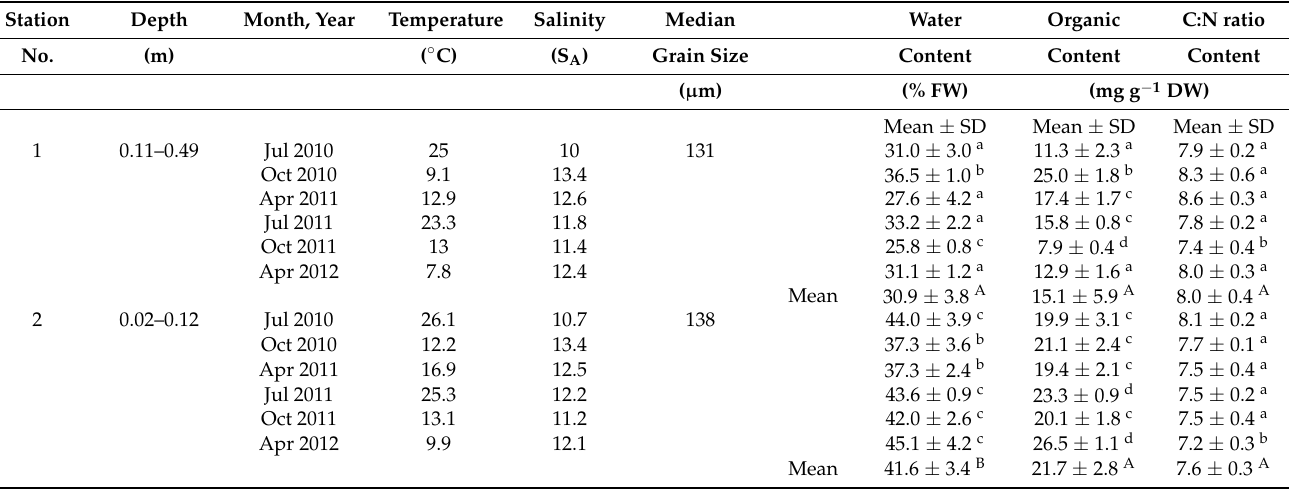
Table 1. Environmental data on both sampling stations in Boiensdorf (54 ◦ 01.490 (cid:48) N, 11 ◦ 32.110 (cid:48) E). Soft bottom samples were taken between July 2010 and April 2012. Temperature, salinity, and mean grain size are given. For water content, organic matter and molar CN ratio sediment cores were sampled in the field at different time points. Mean values ± standard deviation are given ( n = 12–15). Different lowercase and uppercase letters reflect the results of the one-way ANOVA (significant differences among all means using Tukey’s test, p <